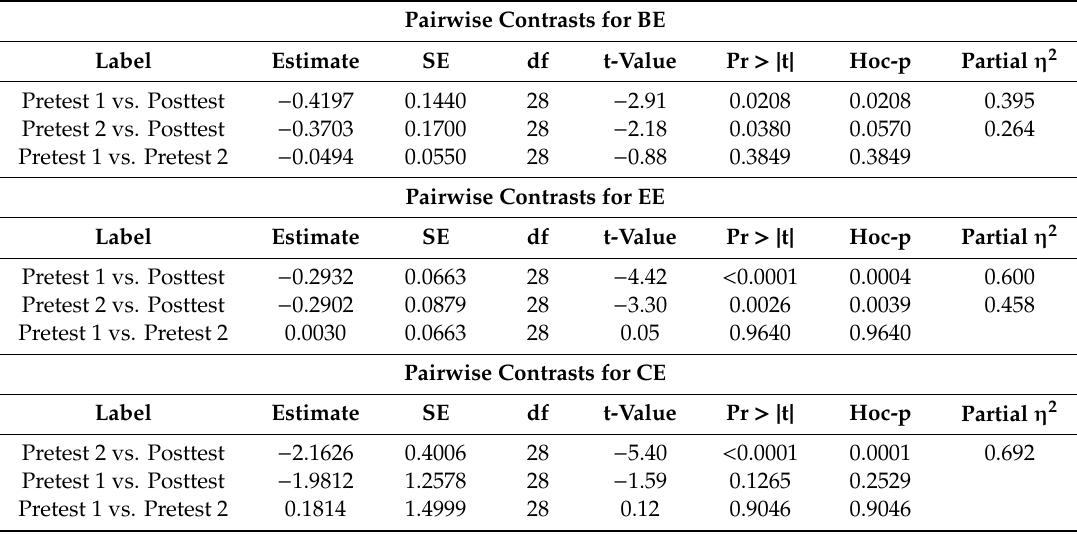
Table 4. Hochberg’s adjusted p values and observed size e ff ects for all possible pair-wise di ff erences among the levels of the within-subjects